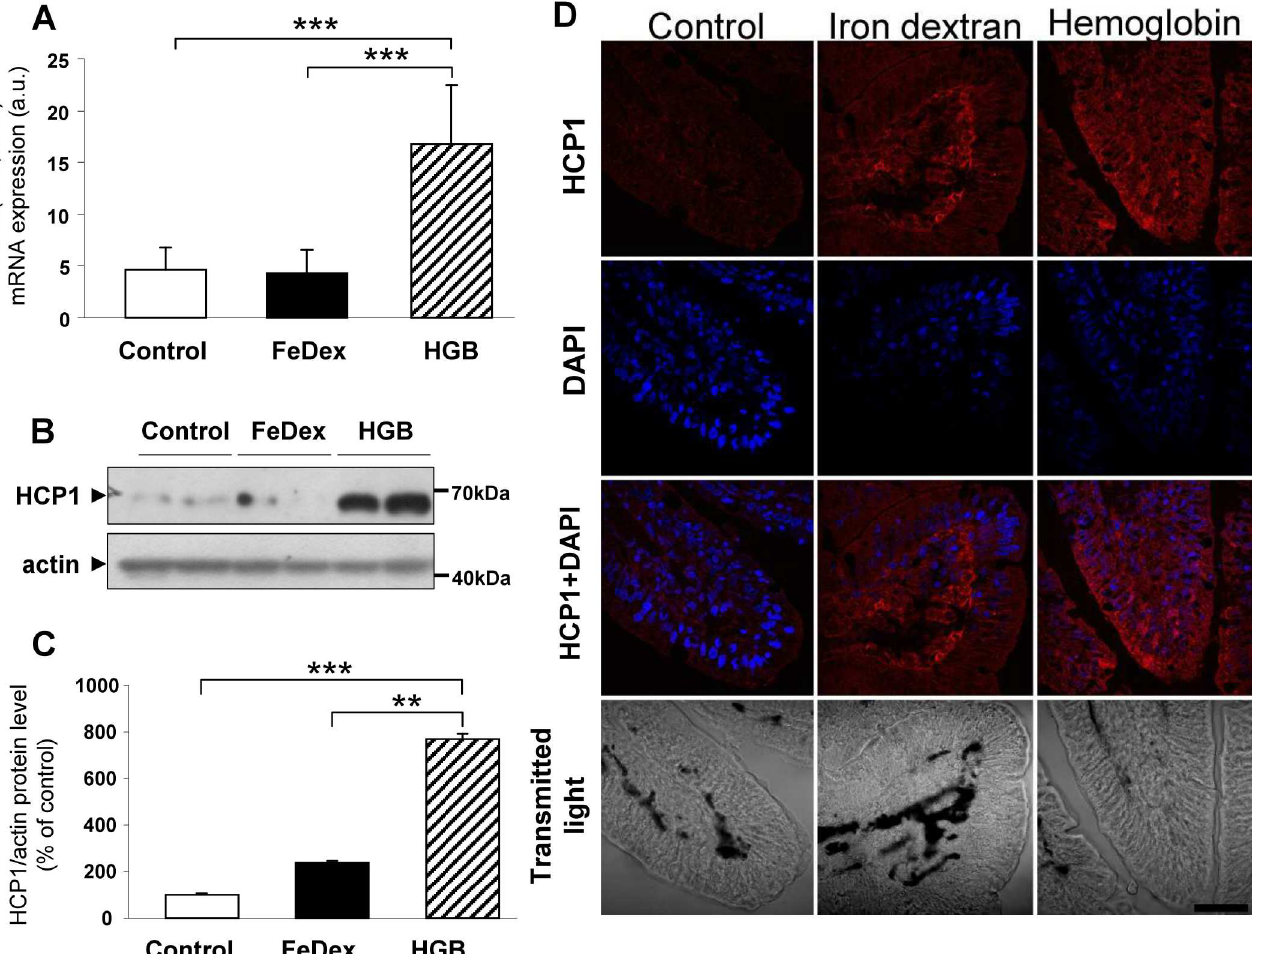
Fig 2. Increased HCP1 expression on the apical membrane of absorptive enterocytes of piglets fed a hemoglobin-enriched diet. (A) RT- qPCR analysisof HCP1 mRNA expression. The histogram displaysHCP1 mRNA levels in arbitrary units (means ± S.D., n = 7). (B and C) Western blot analysisof HCP1 protein levels in membranefractions preparedfrom duodenal scrapings.A representative immunoblot is shown (B) . Immunolabelled HCP1 bandsfrom separateblots performed on scrapingsisolated from 6 piglets were quantifiedusing a MolecularImager, and HCP1 protein levels (means ± S.D.) are plotted in arbitrary units (C) . (D) Immunofluorescent stainingof HCP1 in the duodenum. To confirm the specificity of HCP1 detection, piglet duodenumsections were incubatedwith only the secondary antibody. No HCP1 staining was detected in these negativecontrols. Counterstaining of nuclei was performed with DAPI. Duodenummorphology is shownin transmitted light.